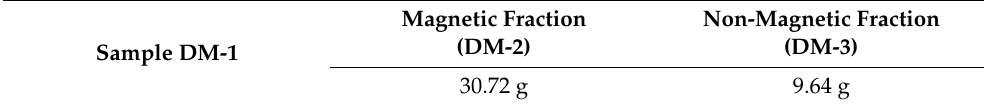
Table 6. Weight split for sample DM-1 after magnetic separation at 0.7 A.